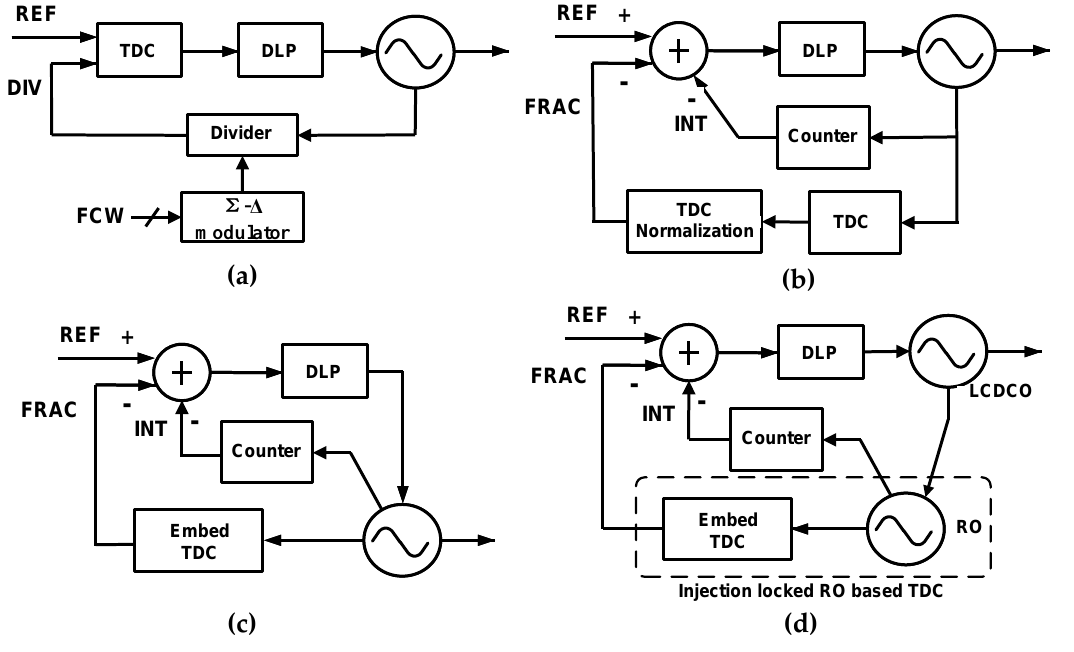
Figure 1. ( a ) Divider-based ADPLL; ( b ) Counter-based ADPLL; ( c ) Counter-based ADPLL with embed TDC; ( d ) Counter-based ADPLL with injection-locked RO based